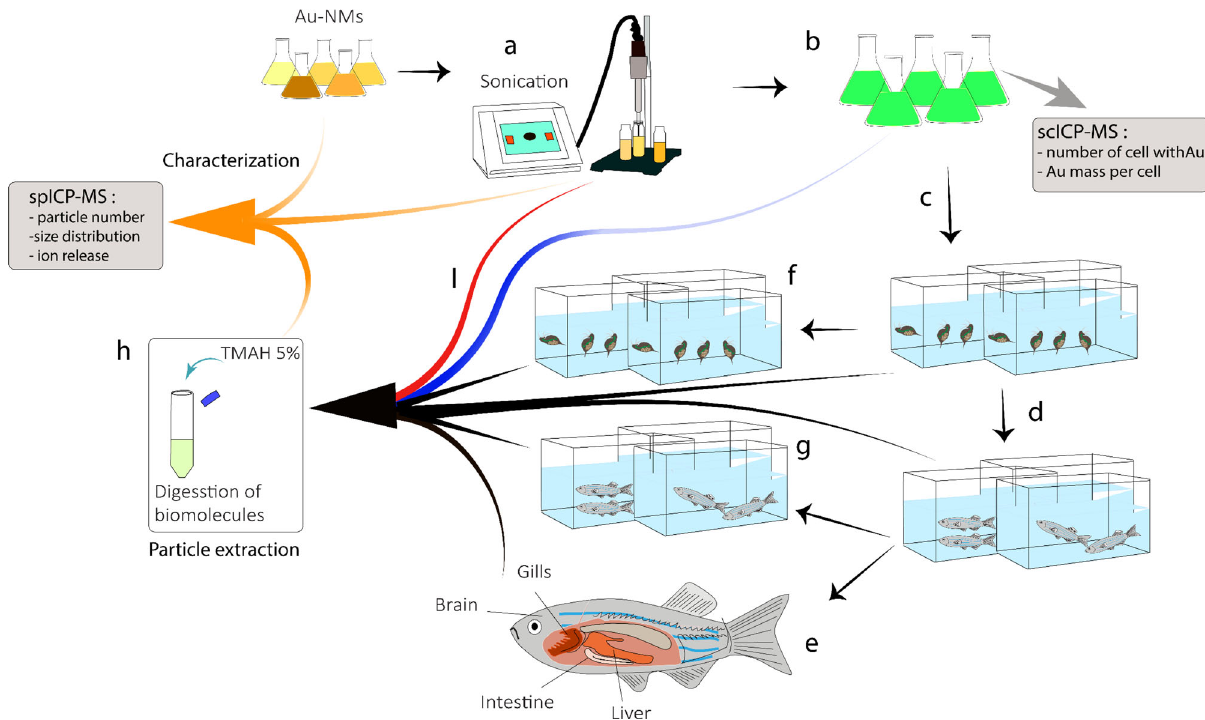
Fig. 5 The experimental design and method validation. The gold (Au)-nanomaterials (NMs) were dispersed in Milli-Q (MQ) water and sonicated using a tip sonicator ( a ). Some of the Au-NM dispersion samples were measured using single-particle inductively coupled plasma mass spectrometry (spICP-MS) before and after the sonication (green arrows) to evaluate the in fl uence of the sample preparation process on the Au-NMs physicochemical